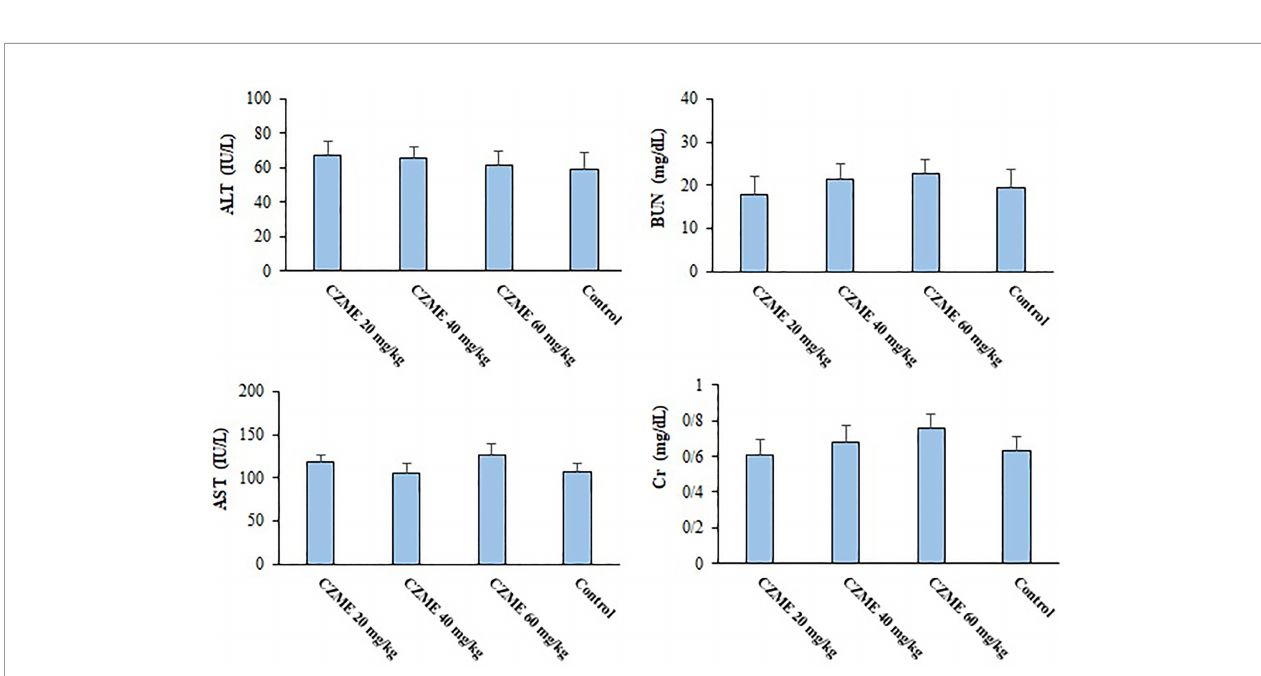
FIGURE 6 | The effects of C. zeylanicum methanolic extract (CZME) on the level of aspartate aminotransferase (AST), alanine aminotransferase (ALT), Blood Urea Nitrogen (BUN) and Creatinine (Cr) in the healthy mice. Mean ±